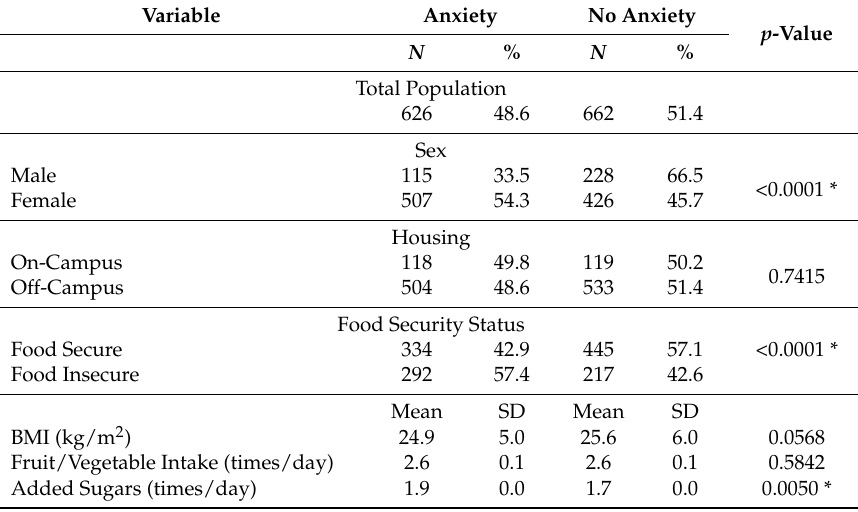
Table 2. Characteristics of respondents and correlations with anxiety